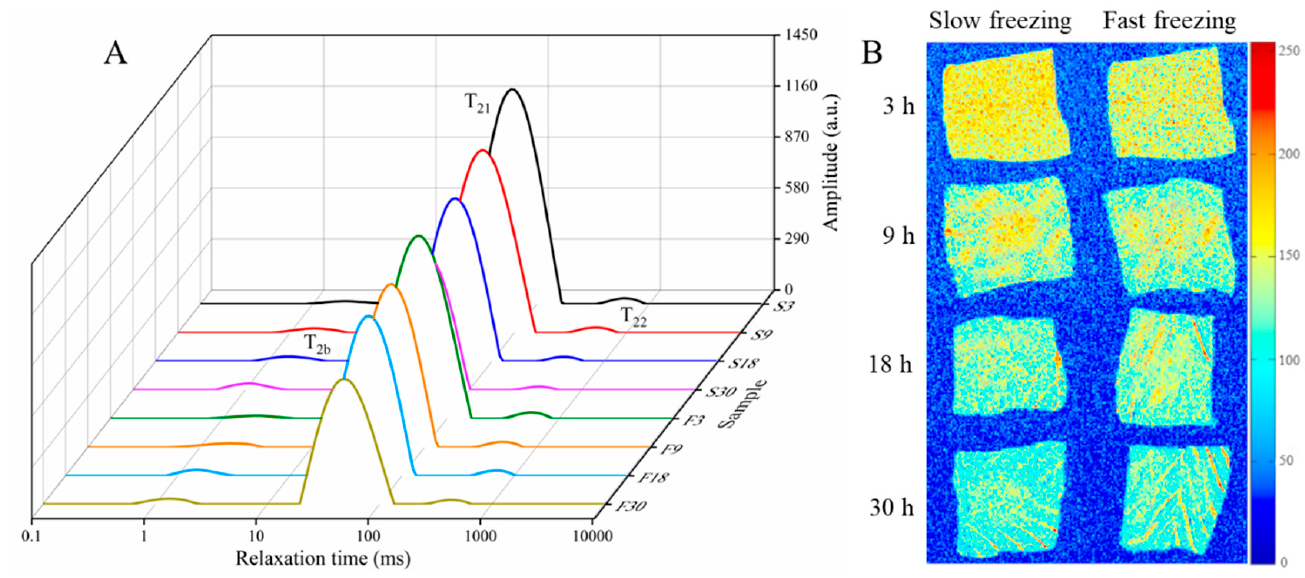
Figure 3. Transverse relaxation time (T 2 ) curves ( A ) and MRI pseudocolor images ( B ) of thawed large yellow croakers during dehydration. Table 1. NMR parameters, unfrozen water content, and total SH content of large yellow croakers during dehydration. Sample